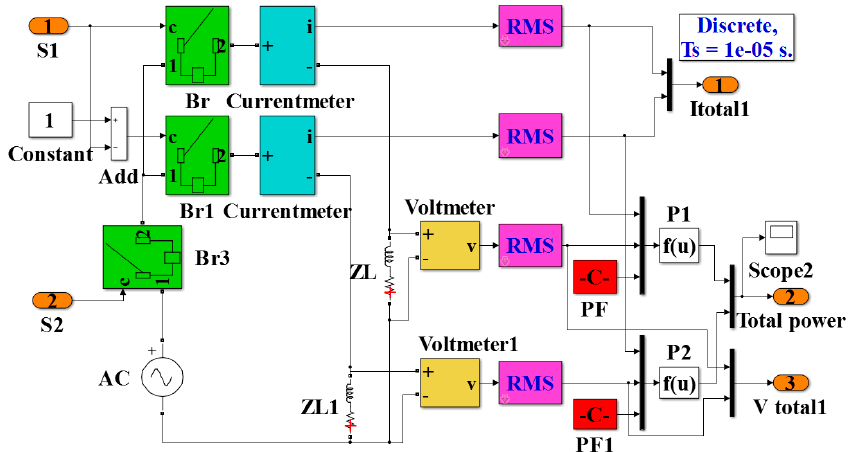
Figure 7. Simulation model of REF.